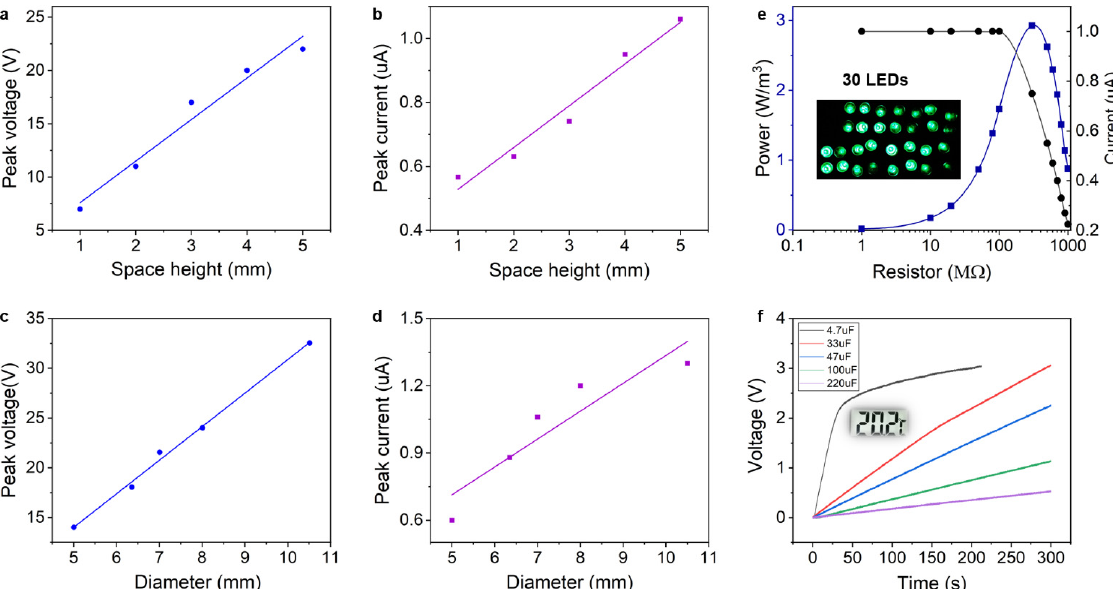
Figure 5. The power generation performance of the BB-TENG. ( a ) Maximum open-circuit voltage and ( b ) maximum short-circuit current of the BB-TENG with a ball diameter of 7 mm at different container cylinder height. ( c ) Maximum open-circuit voltage and ( d ) maximum short-circuit current of the BB-TENG with different ball diameter. ( e ) Output power and current of the BB-TENG in series with different load resisters and ( f ) different capacitors charged by BB-TENG with ball diameter of 10.5 mm.